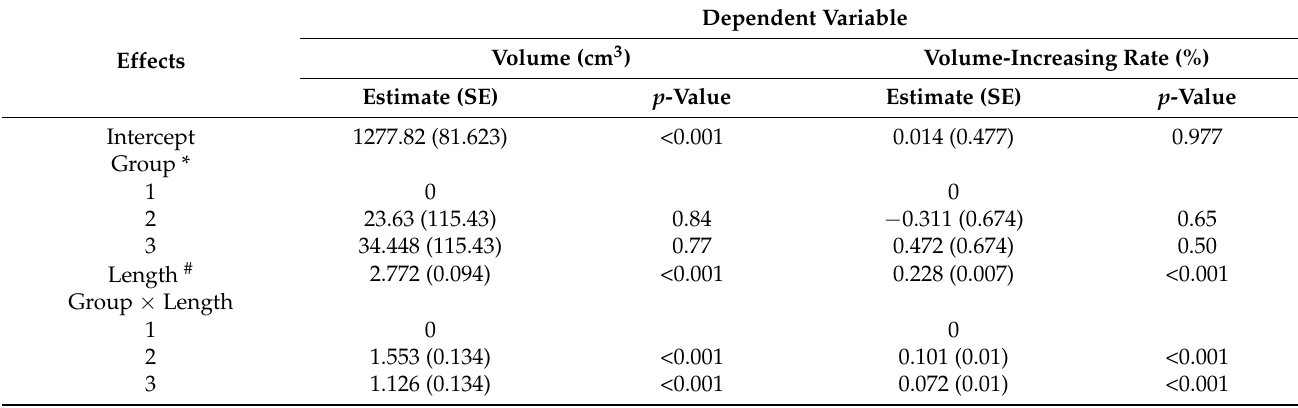
Table 5. Interaction between elevation height of contour and skull defect size for volume and volume-increasing rate of 15 CAD models.